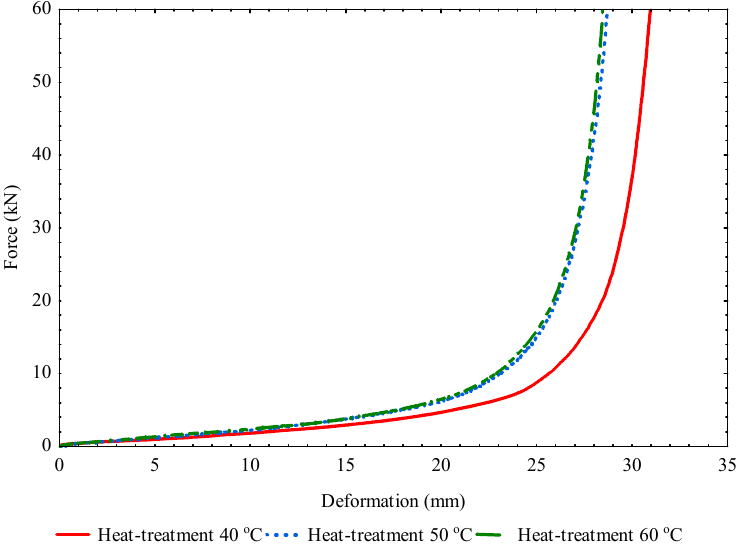
Figure 3. Force–deformation curves of bulk hazelnut kernels for heating temperatures.